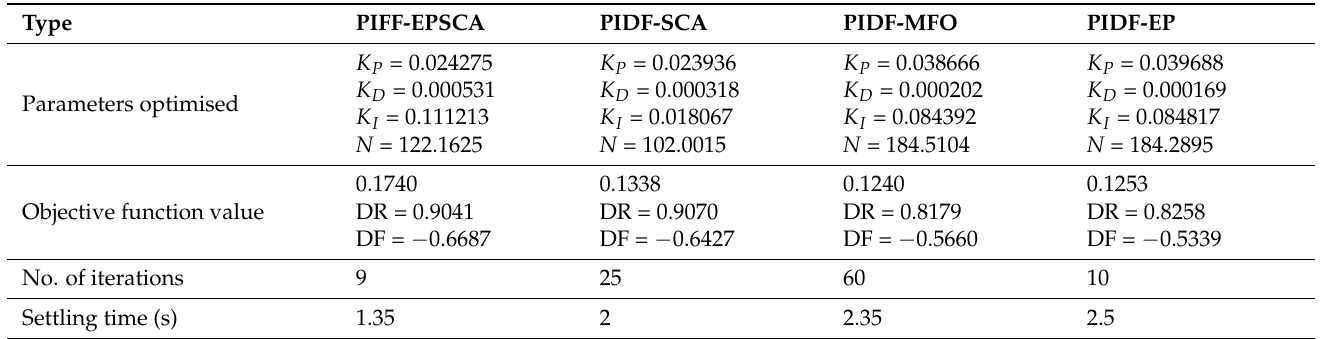
Table 3. Comparison of PIDF-EPSCA, PIDF-SCA, PIDF-MFO, and PIDF-EP for Scenario A-1.